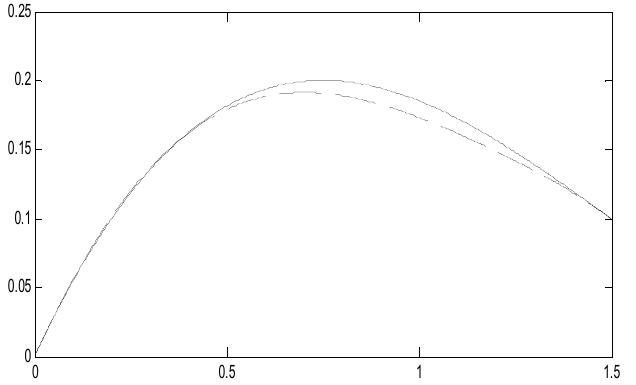
Figure 19. Case 2: Evolution of the trajectory of the robot in the Cartesian coordinate system.